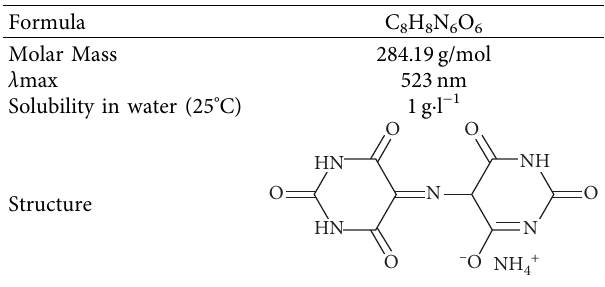
Table 1: Murexide